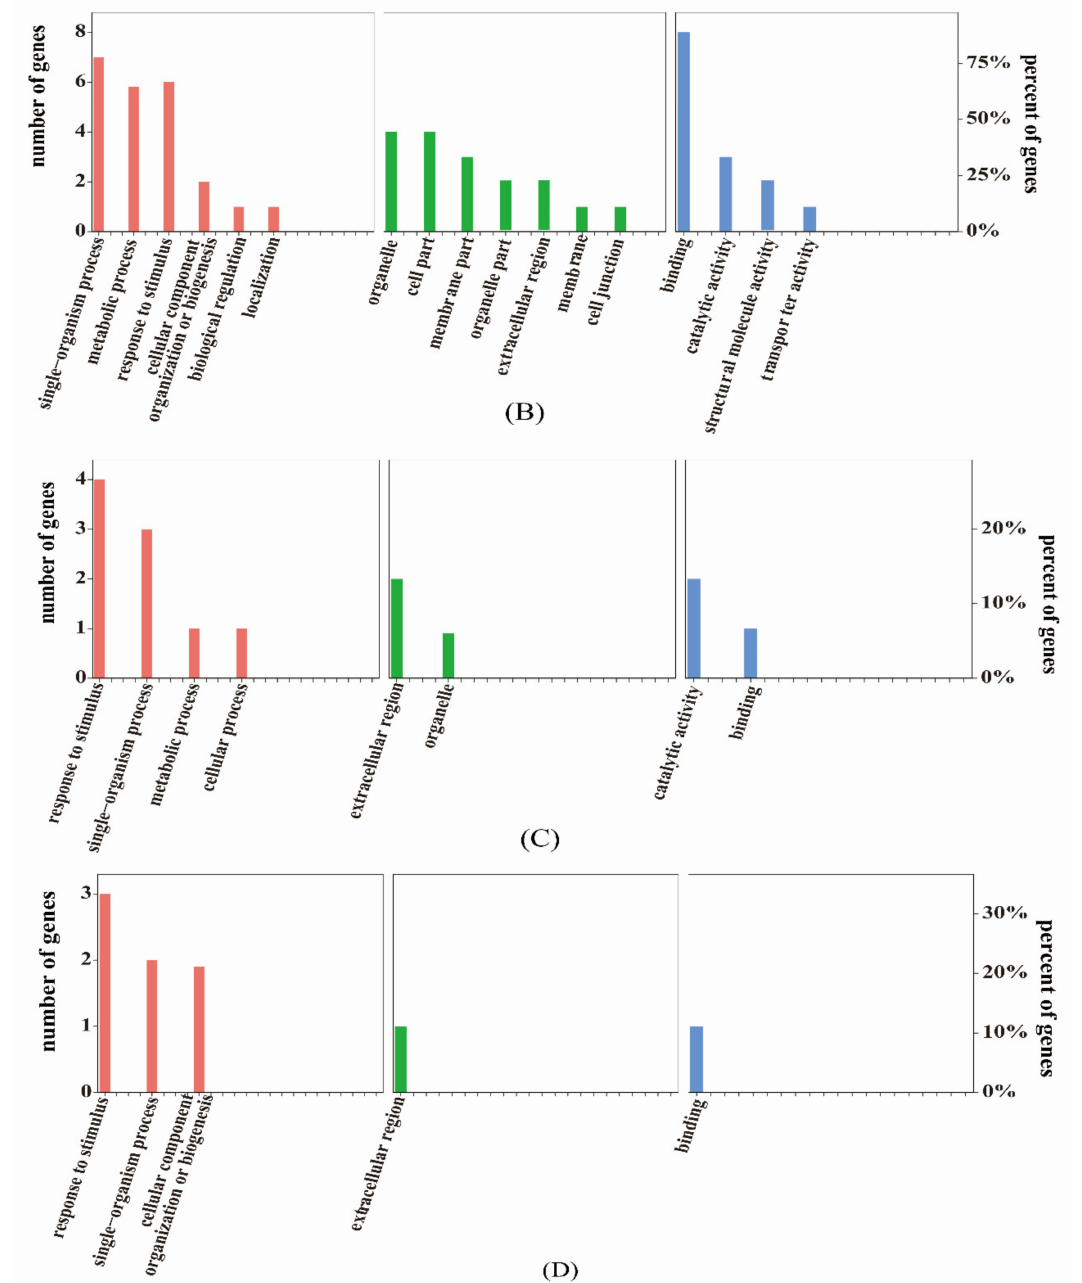
Figure 6. Gene ontology (GO) association analysis of the proteome and transcriptome data. ( A ) represents the expression trends of differentially expressed genes and proteins that are the same as that of the differentially expressed genes in the GO association analysis. ( B ) represents the expression trends of differentially expressed genes and proteins that are opposite to that of the differentially expressed genes the GO association analysis. ( C ) represents the expression trends of differentially expressed genes and proteins that are the same as that of the differentially abundant proteins in the GO association analysis. ( D ) represents the expression trends of differentially expressed genes and proteins that are the same as that of the differentially abundant proteins in the GO association